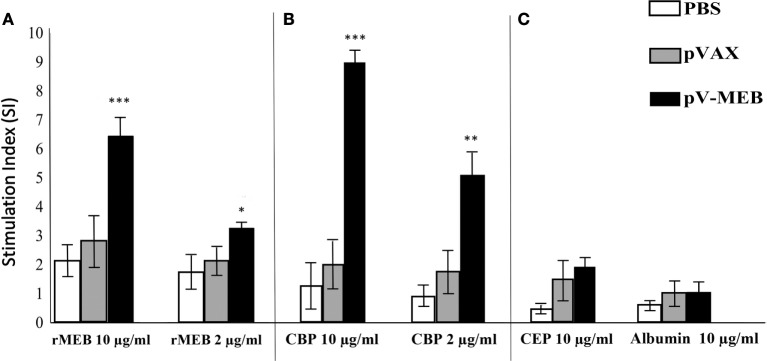
Lymphocyte proliferation assay after in vitro stimulation with (A) 10 or 2 µg/ml recombinant protein, (B) 10 or 2 µg/ml Brucella abortus total proteins (CBP), and (C) 10 µg/ml of crude Escherichia coli proteins and 10 µg/ml of albumin as control. Results are shown as mean ± SD of the stimulation index of 3H-thymidine, incorporated from mouse splenocytes (n = 5) (*P < 0.05, **P < 0.01, and ***P < 0.001).